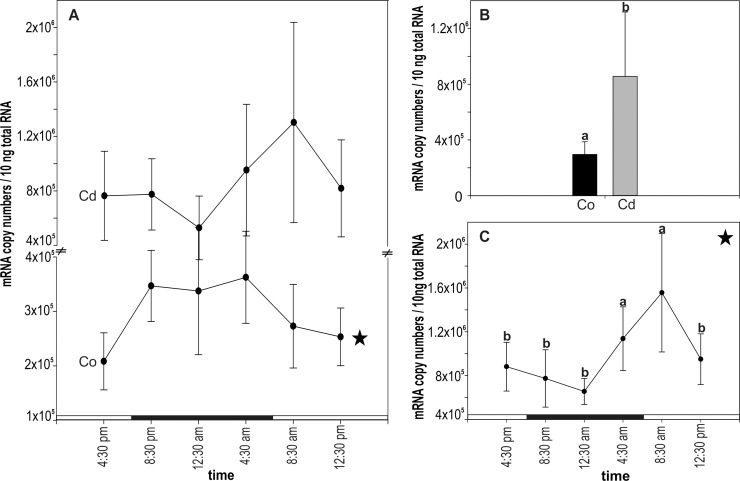
Diurnal rhythmicity of CdMT gene expression of control and Cd-exposed Roman snails.(A) CdMT mRNA copy numbers over a time span of 20 hours, including six sampling time points, in control (Co) and Cd-exposed snails (Cd) (n = 5). Significance of the curves through the diurnal cycle (Two Way ANOVA) was only observed for unexposed control snails (asterisk). No significant differences were found by multiple comparisons within the control and Cd-treated group. (B) Bar graph with means and standard deviation (+SD) of CdMT mRNA copy numbers between control and Cd-exposed individuals (n = 30 each). Different lowercase letters (a, b) indicate significant differences (t-test) (C) Time-dependent CdMT mRNA expression of Cd-exposed snails (P = <0.001) over a time span of 20 hours, shown after exclusion of non-feeders (definition see text) from the dataset (n = 3–5). The peak of CdMT mRNA copy numbers at 08:30 am was compared to all other time points. Significance of multiple comparison is indicated by different lower case letter b. Significance of Two Way ANOVA is indicated by an asterisk. The light period (long white bars) lasted from 07:00 am to 07:00 pm and dark period (long black bars) from 07:00 pm to 07:00 am.